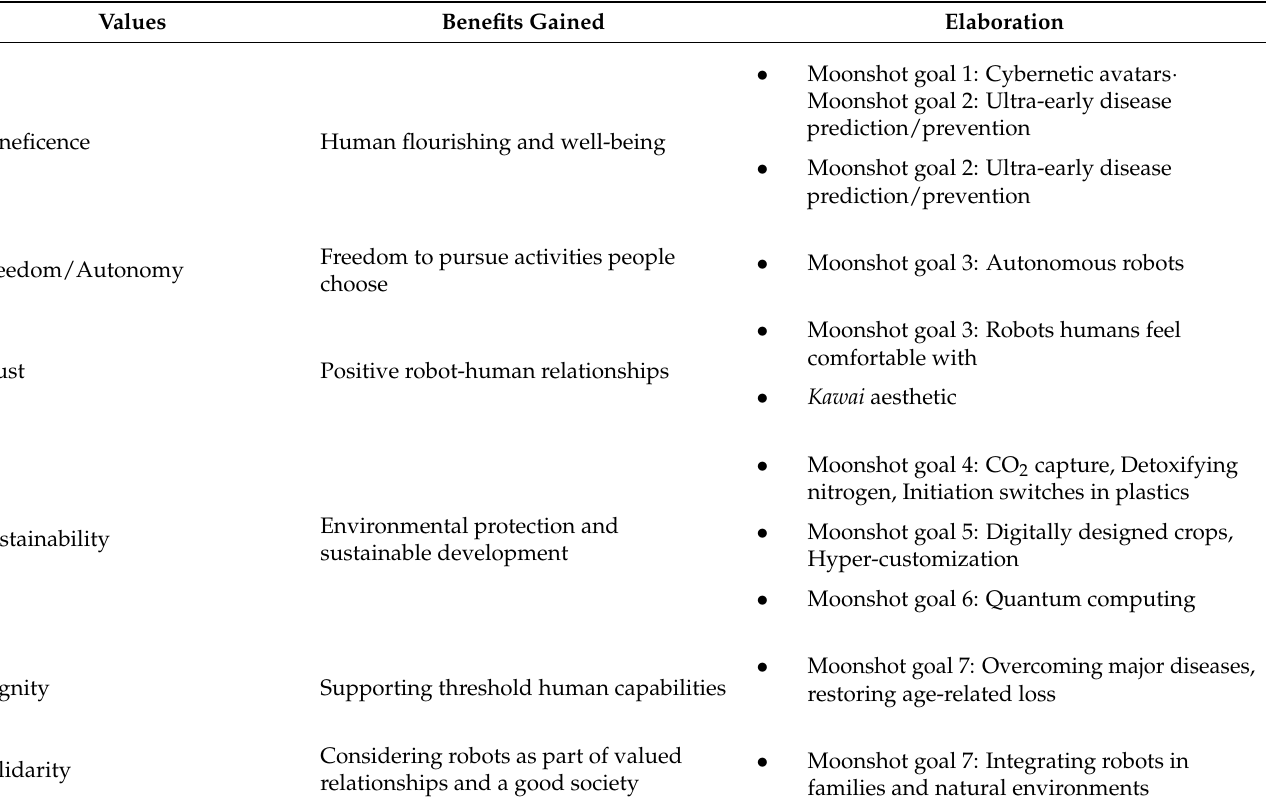
Table 3. Positive Values in International AI Ethics